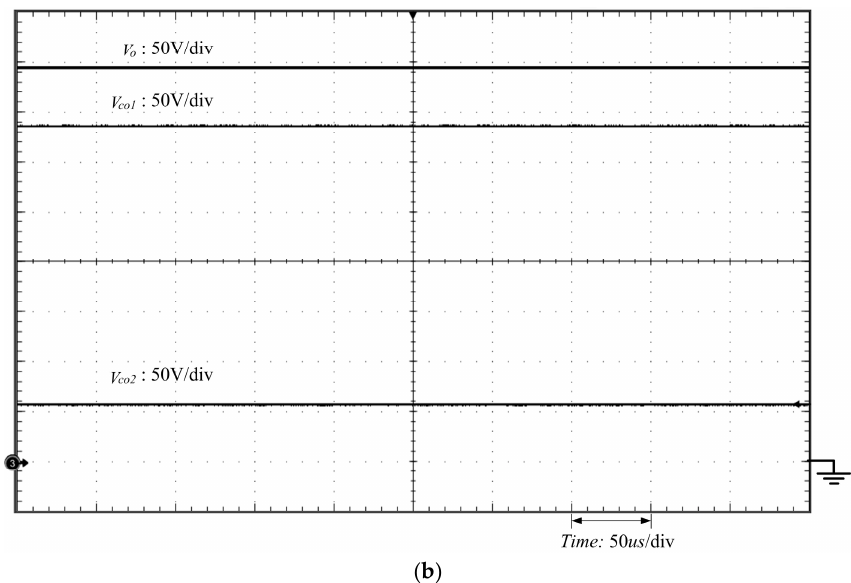
Figure 10. Experiment waveform under full-load P o = 150 W. ( a ) Measured waveforms of v 1 , v 2 and v 3 ; ( b ) Measured waveforms of V co 1 , V co 2 and V o .